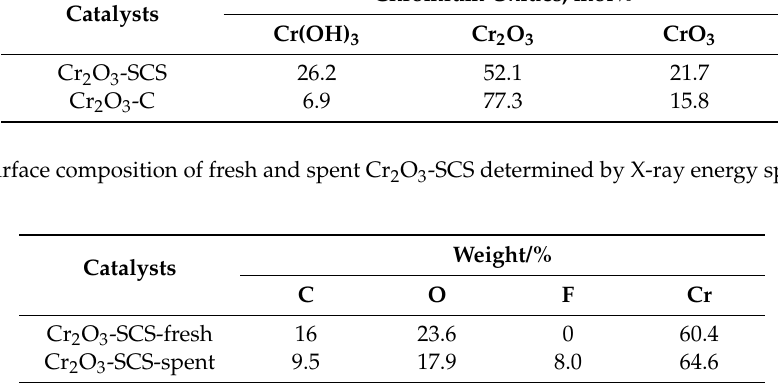
Catalysts Table 4. Surface composition of fresh and spent Cr 2 O 3 -SCS determined by X-ray energy spectrometer (EDS). Catalysts